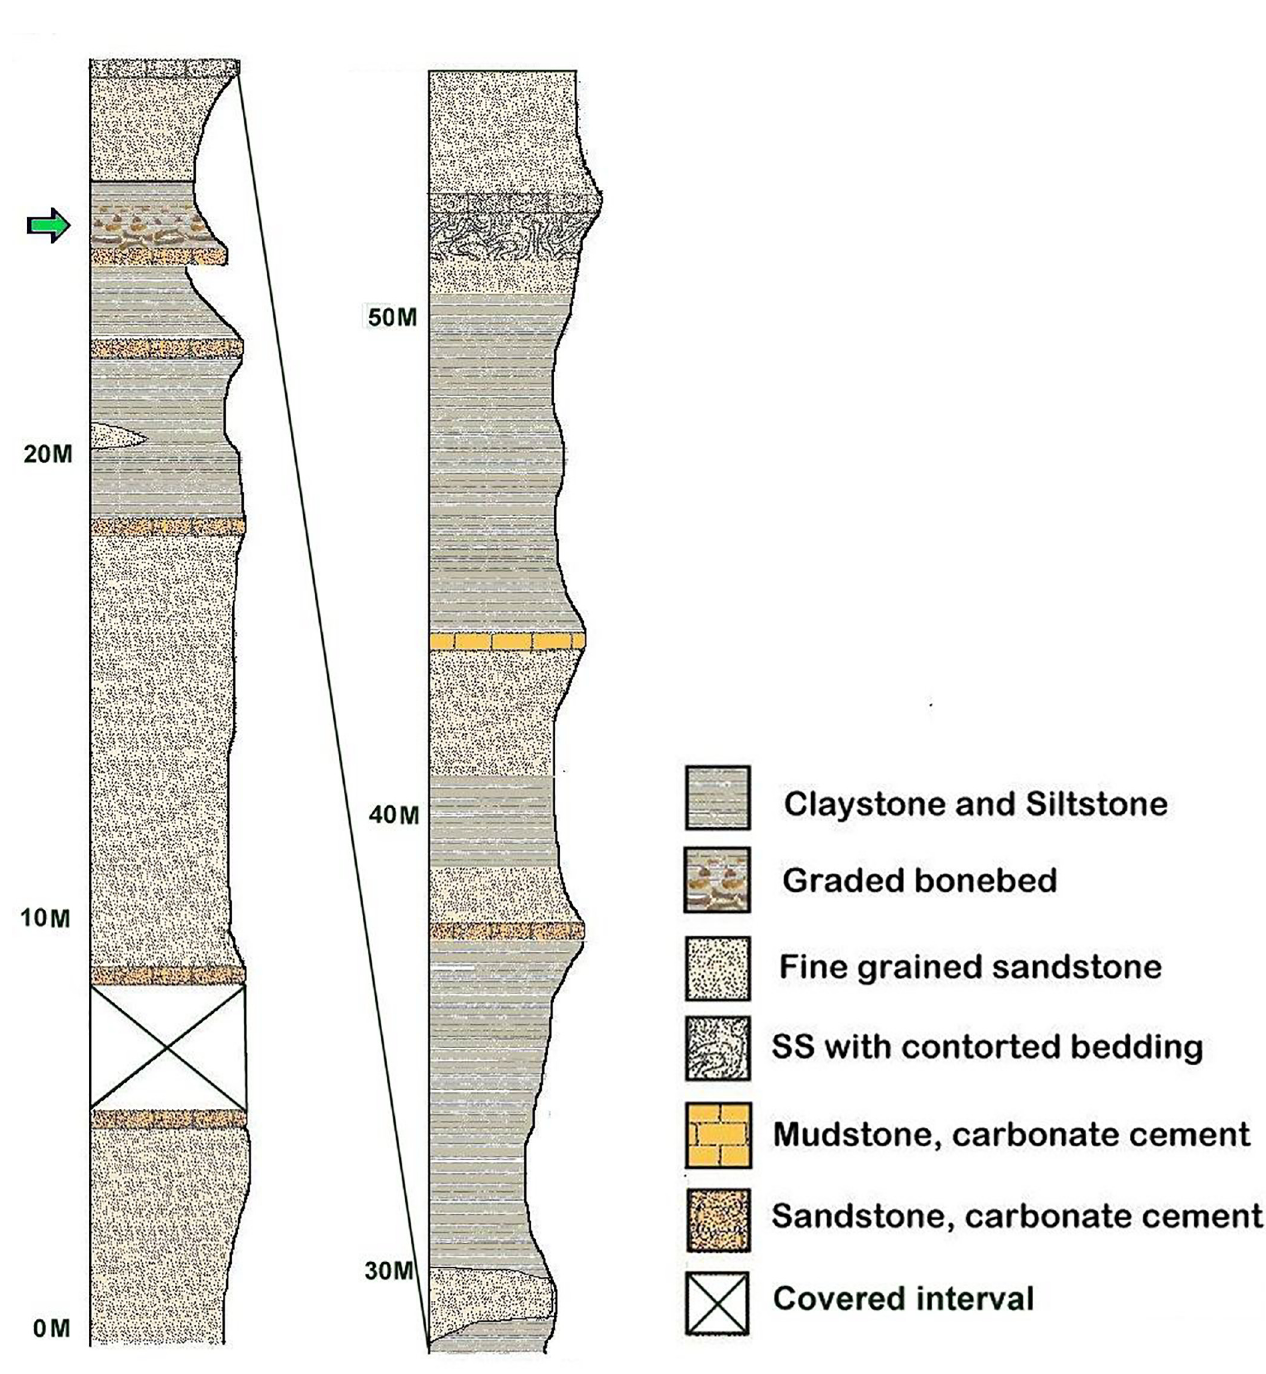
Fig 3. Local stratigraphy of the main bonebeds at the hanson research station. Units in meters above arbitrary base. Green arrow designates position of main bonebed in section.